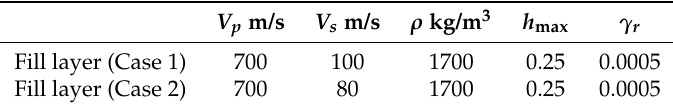
Figure 8. Distribution of maximum axial tensile strain for cases with different fill-layer material properties. White lines indicate boundary between cut-and-fill layers. White circles indicate positions of pipeline damage. ( a ) Standard case (maximum strain = 0.00357); ( b ) Case 1: with small γ r (maximum strain = 0.00345); ( c ) Case 2: with small γ r and small V s (maximum strain = 0.00488). Table 2. Material properties for Cases 1 and 2. Material properties of cut layer and bedrock are those of standard case. Here, V p , V s , ρ , h max , and γ r indicate primary wave velocity, secondary wave velocity, density, maximum damping, and reference strain, respectively. V p m/s V s m/s ρ kg/m